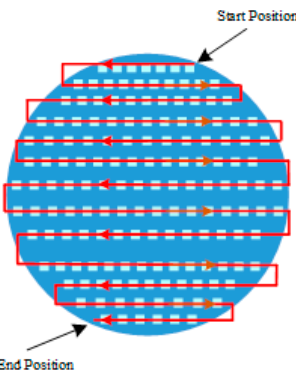
Figure 7. Schematic diagram of scanning path.